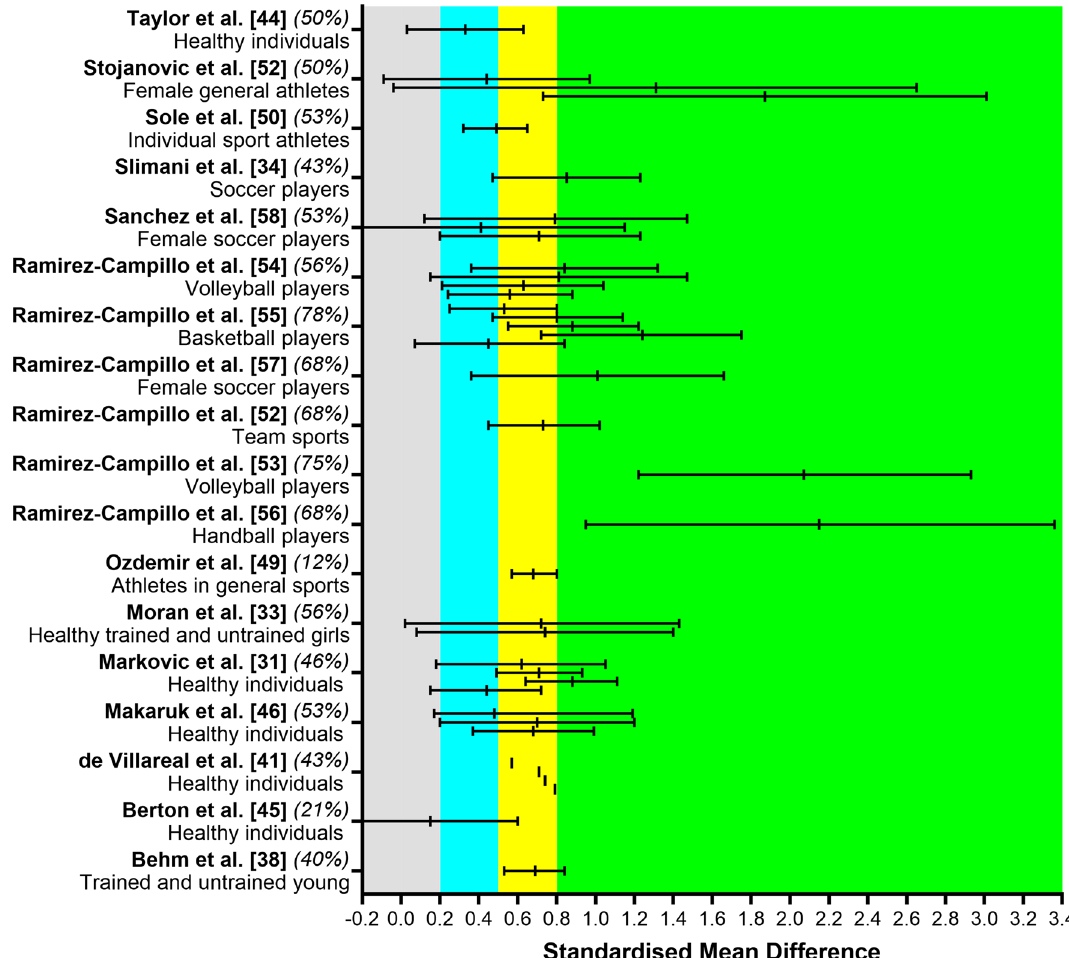
Fig. 6 Summary of standardized mean difference and 95% confidence intervals reported in meta‑analyses comparing the baseline to post‑plyometric training changes on jump performance. Author name and year are followed by the quality of the studies score ranked with the AMSTAR 2. Positive values represent improved performance effects and negative values detrimental effects. Each colored area represents a different magnitude of effect: gray trivial, blue small, yellow moderate, and green large effects, while the red area represents detrimental = = = =